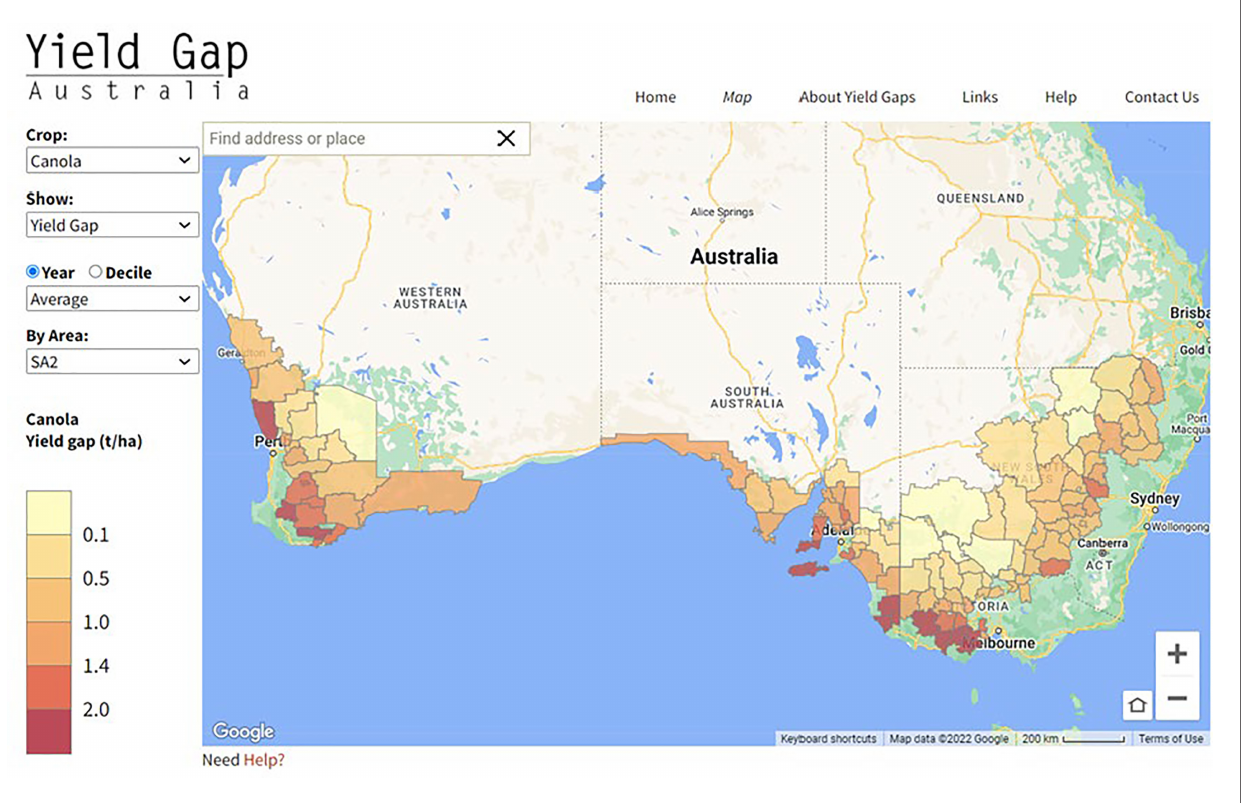
FIGURE 5 | Yield as reported by Yield Gaps Australia (https://yieldgapaustralia.com.au/maps/Retrieved